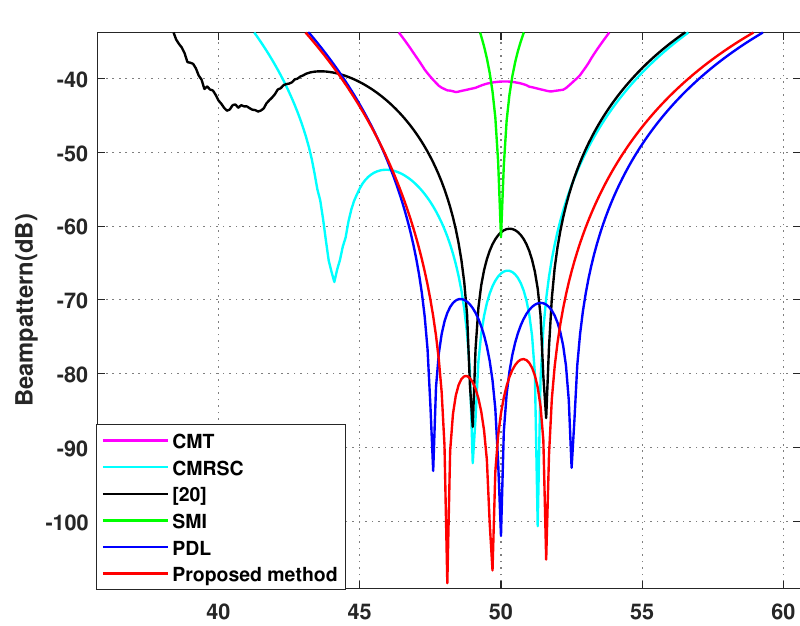
Figure 11. Local enlargement of 50 ◦ . Simulation 4. Simulation 5. Output SINR